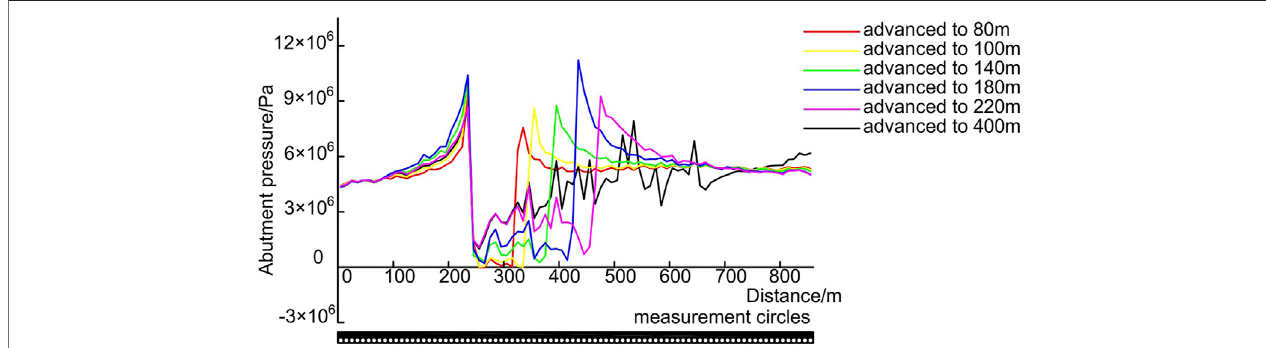
FIGURE 12 | Distribution of the abutment pressure at different advancing distances.